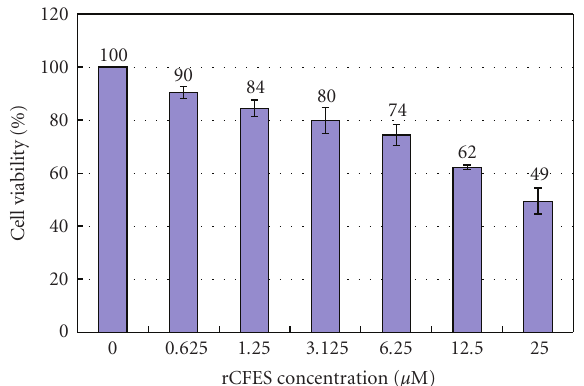
Figure 2: E ff ects of rCFES on WI-38 cell viability, in which the bars indicated the survival rates of WI-38 cells treated with di ff erent concentrations of rCFES. The data are expressed as mean values ( ± standard deviation) of three